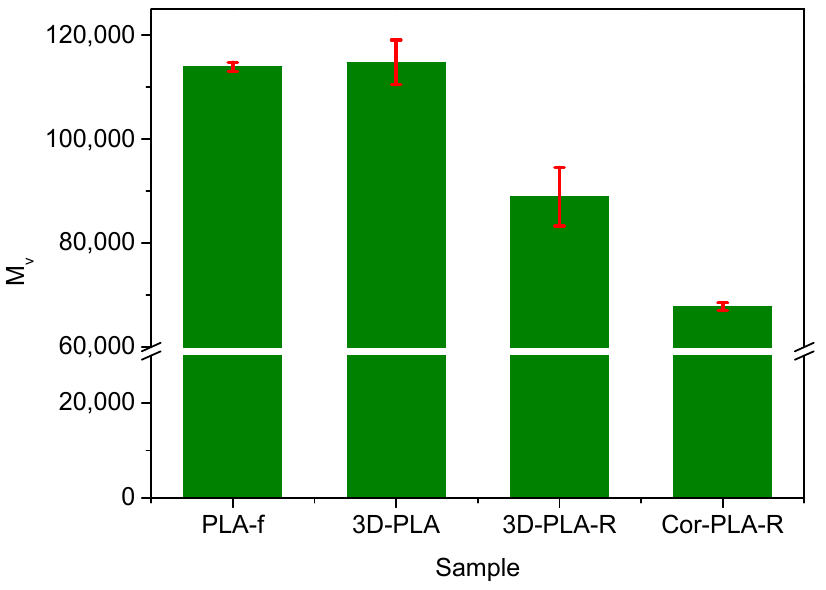
Figure 4. Viscosimetric average molecular weight of the samples before and after mechanical recy ‐ cling.